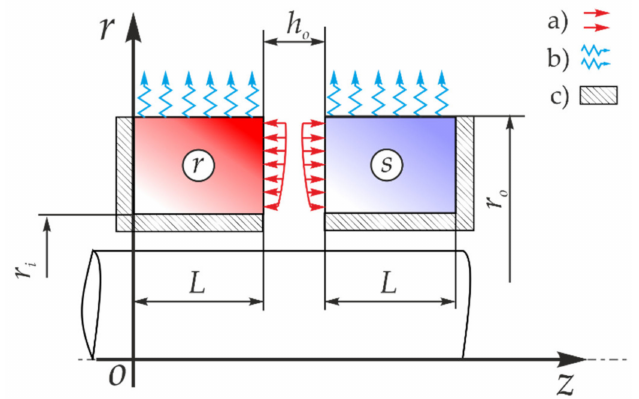
Figure 3. Boundary conditions for the heat transfer in the non-contacting face seal. (a) Heat flux, (b) convection, and (c) insulated